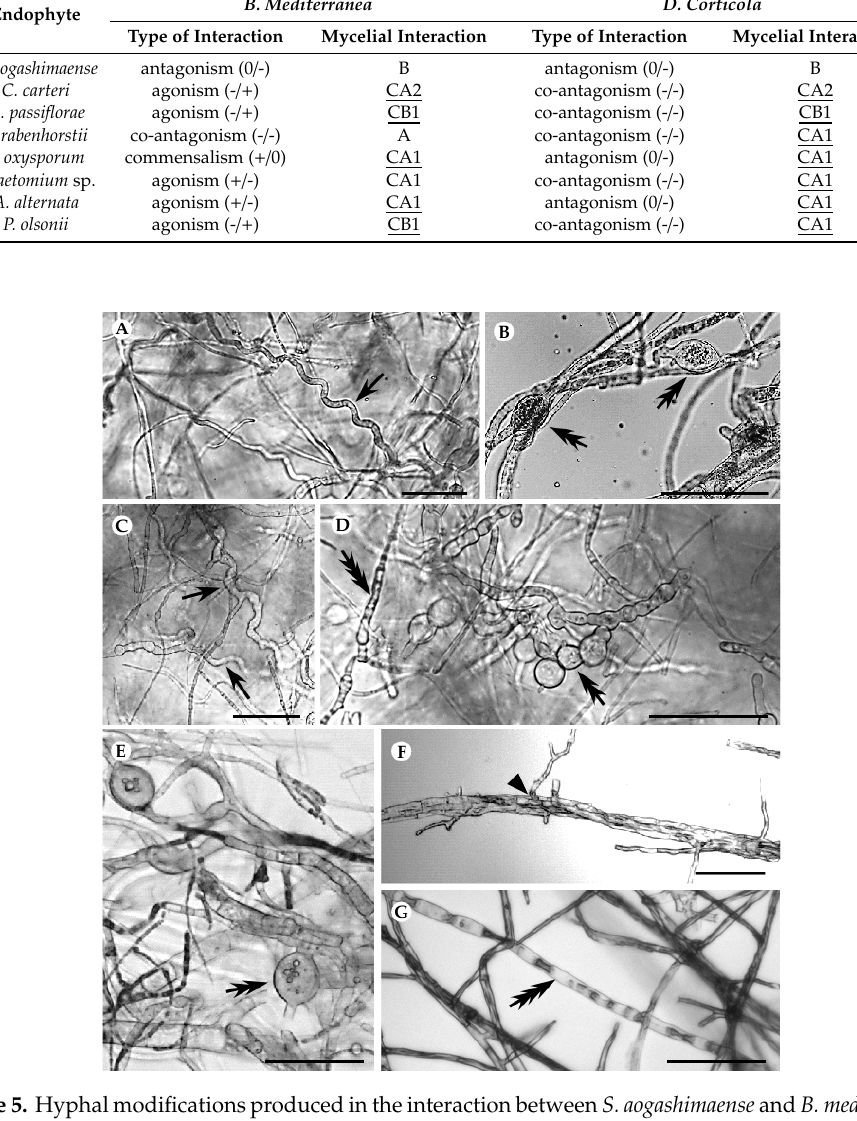
Figure 5. Hyphal modifications produced in the interaction between S. aogashimaense and B. mediterranea ( A , B ), S. aogashimaense and D. corticola ( C , D ) and A. alternata and B. mediterranea ( E – G ). Single arrows designate coiled hyphae, double arrows vesicle-like structures and triple arrows hyphal vacuolization. Black line represents 50 μ M scale.